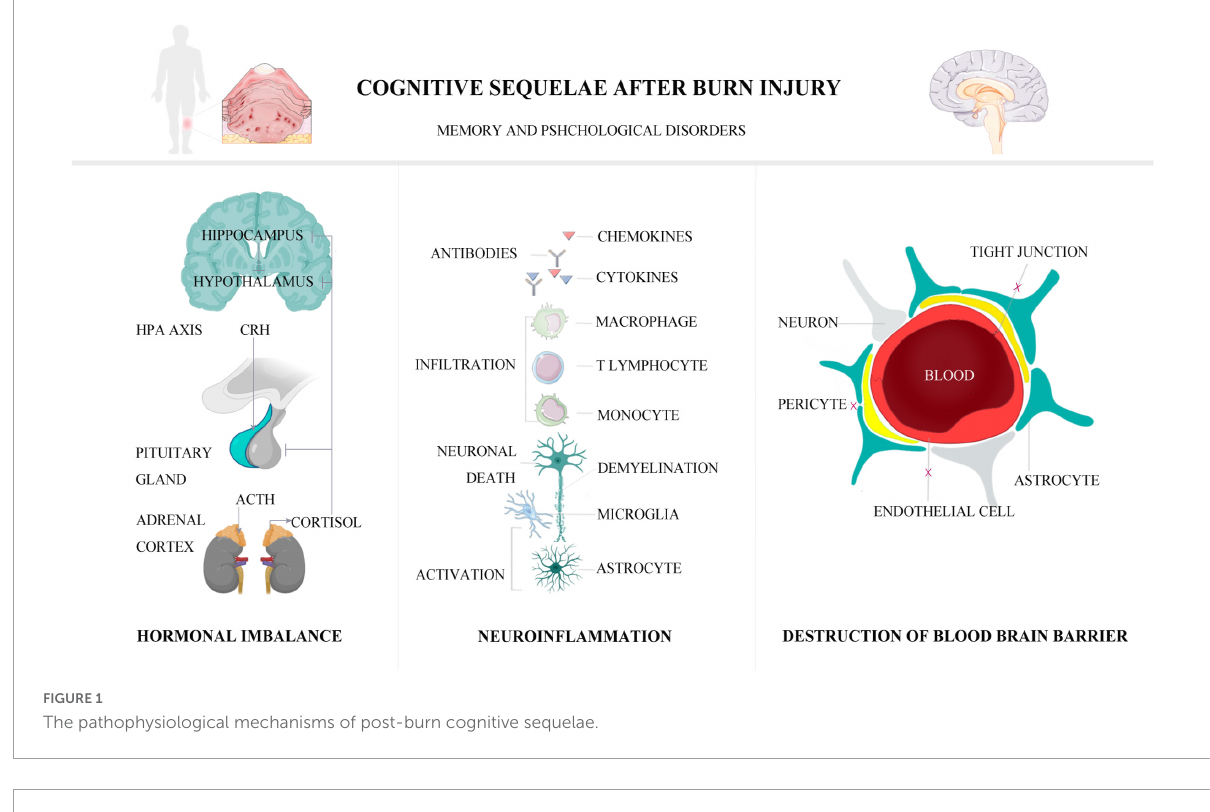
FIGURE1 The pathophysiological mechanisms of post-burn cognitive sequelae.